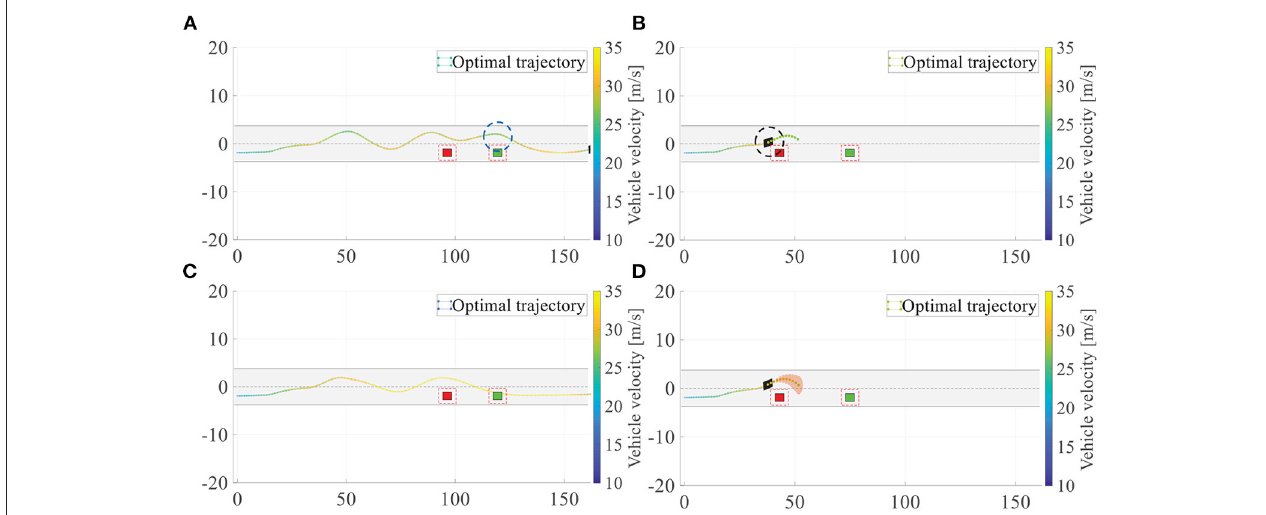
FIGURE 21 | Overtaking maneuvers and the overall driven trajectories for left overtaking. (A) Overall driven trajectories of NMPC; (B) Overtaking maneuver of NMPC; (C) Overall driven trajectories of GPMPC; (D) Overtaking maneuver of GPMPC.